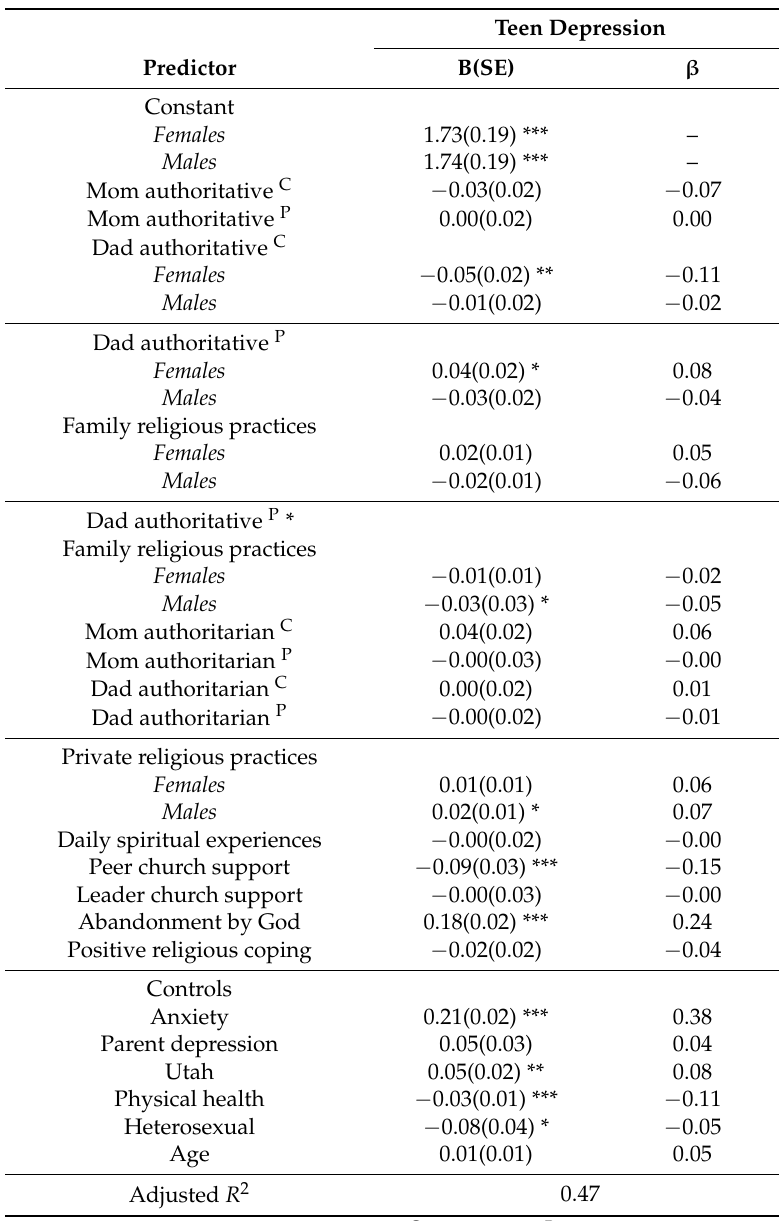
Table 2. Predicting teen depression ( n =